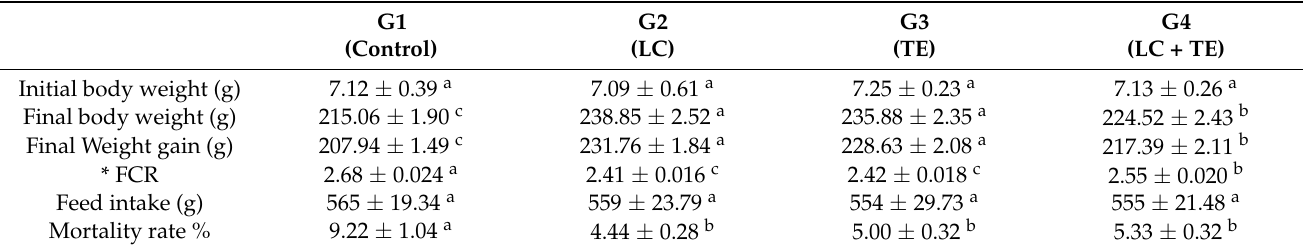
Table 1. Effect L-carnitine and/or calf thymus extract supplementation on growth performance parameters and mortality rate % in Japanese quail (mean ± SE).